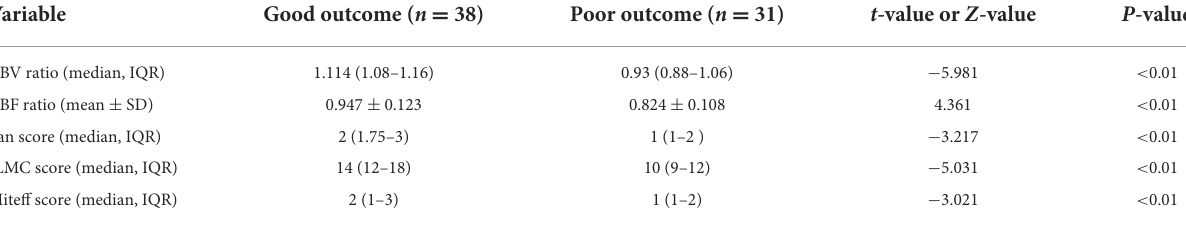
TABLE 2 Comparing CTP parameters and qualitative collateral scores between patients with good and poor outcomes.